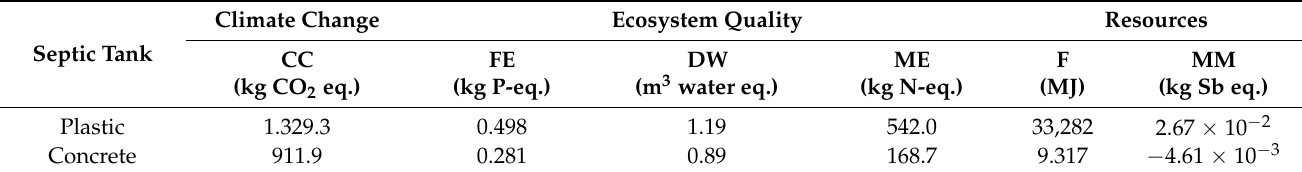
Table 6. Comparison of embodied environmental impacts of plastic vs. concrete septic tanks. Climate Change Ecosystem Quality Septic Tank